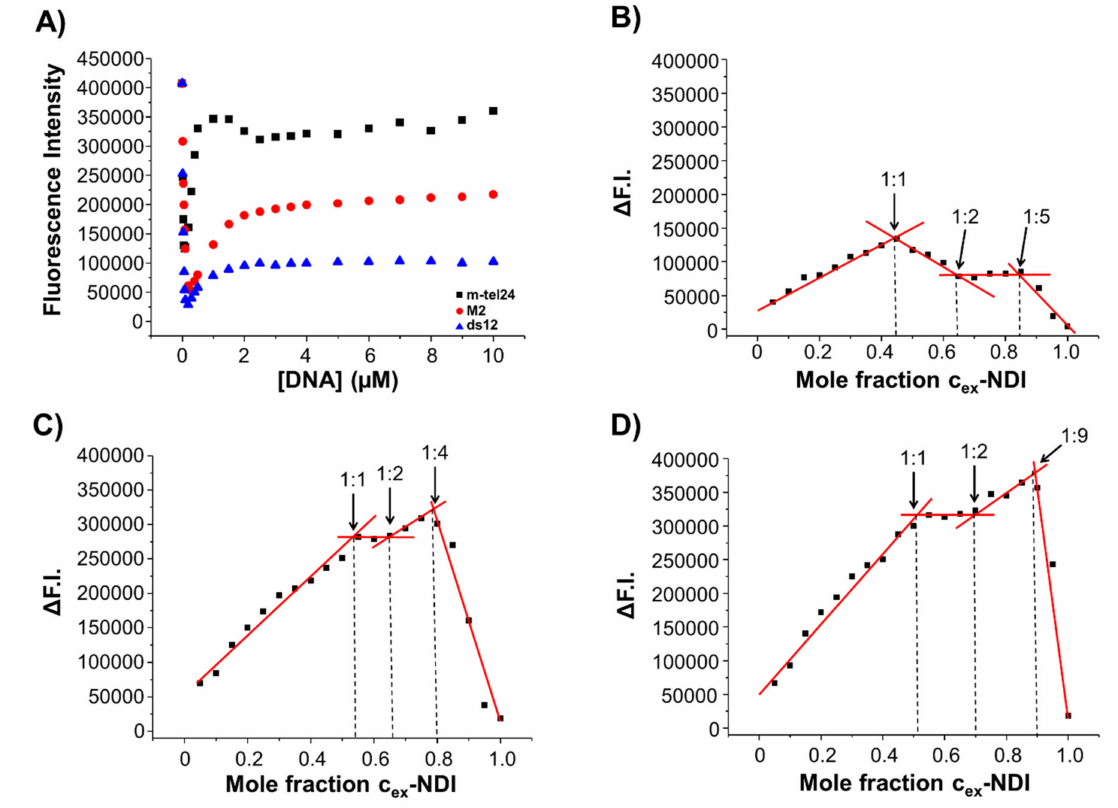
Figure 7. ( A ) Fluorescence titration experiments of c ex -NDI with m-tel24 G-quadruplex (black squares), M2 G-quadruplex (red circles) and ds12 duplex (blue triangles), and Job plot analysis for the binding of c ex -NDI to ( B ) m-tel24 G-quadruplex, ( C ) M2 G-quadruplex and ( D ) ds12 duplex. Labels in panels ( B – D ) indicate the stoichiometries of the different binding events observed for each system. ∆ F.I. is the fluorescence intensity at each point from which the contribution of the ligand alone was